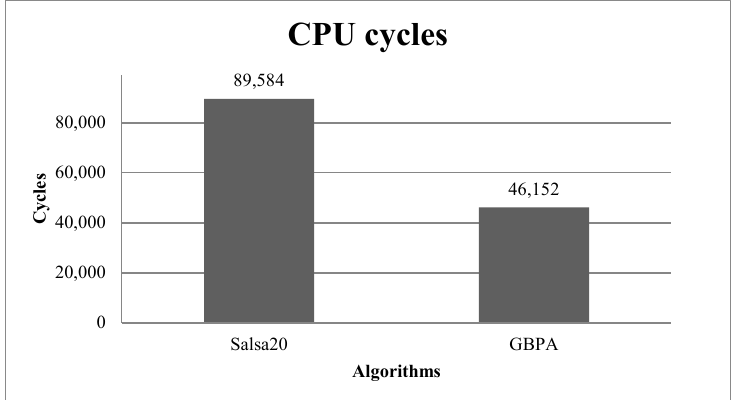
Figure 3. Processor cycle comparison between Salsa20 and GBPA, when generating an output 512 bits long.